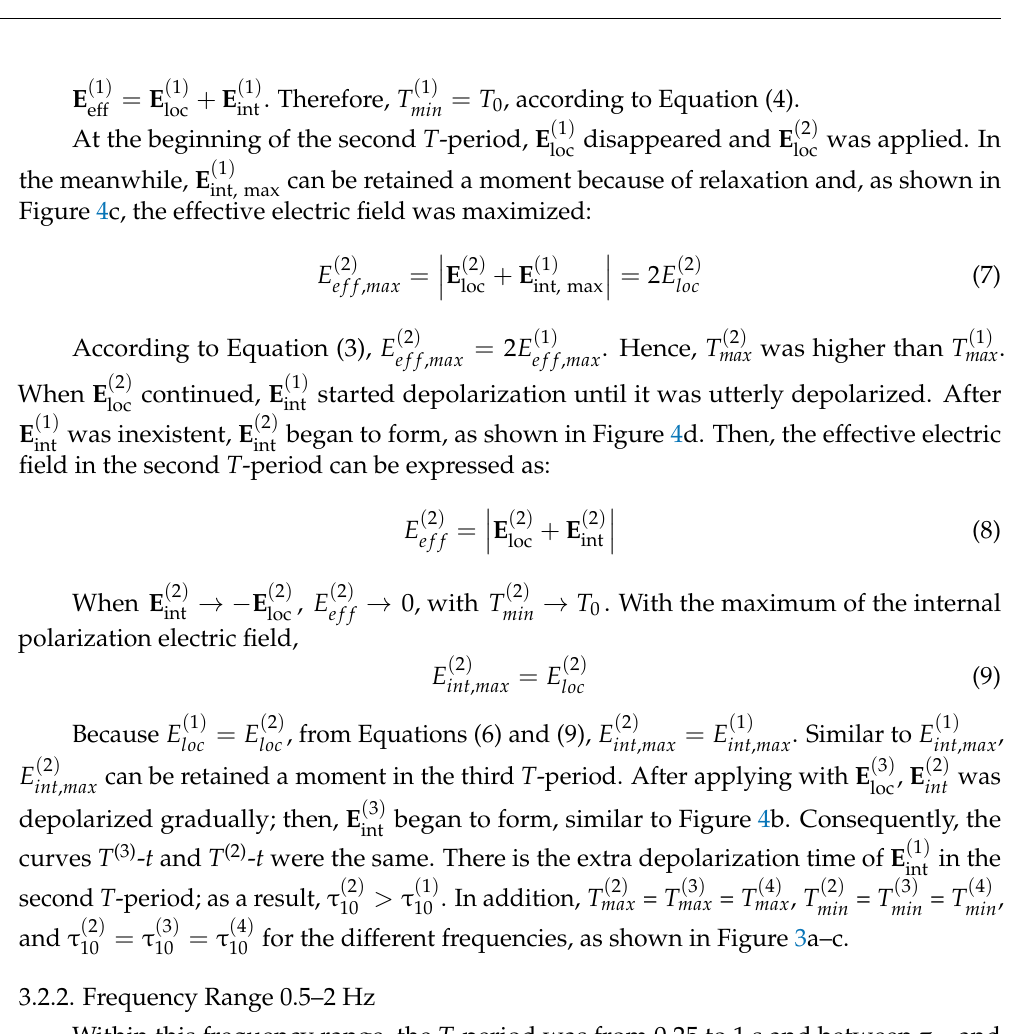
Figure 4. Schematic diagram of the relation between the internal polarization field and the local electric field of the LC droplets. ( a ) The uniform distribution of ions before applying 𝐄 was entirely formed by applying 𝐄 𝐄 int(2) was formed completely after applying 𝐄 loc(2) for long enough.